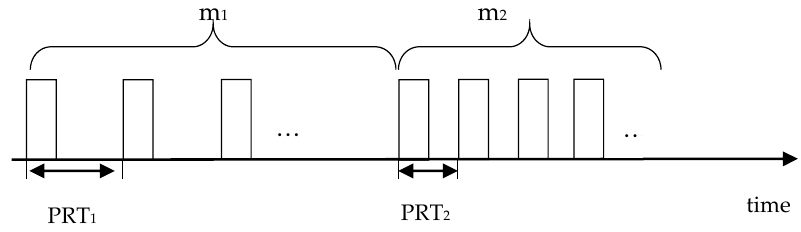
Figure 2. Pulse generation method of batch working mode.